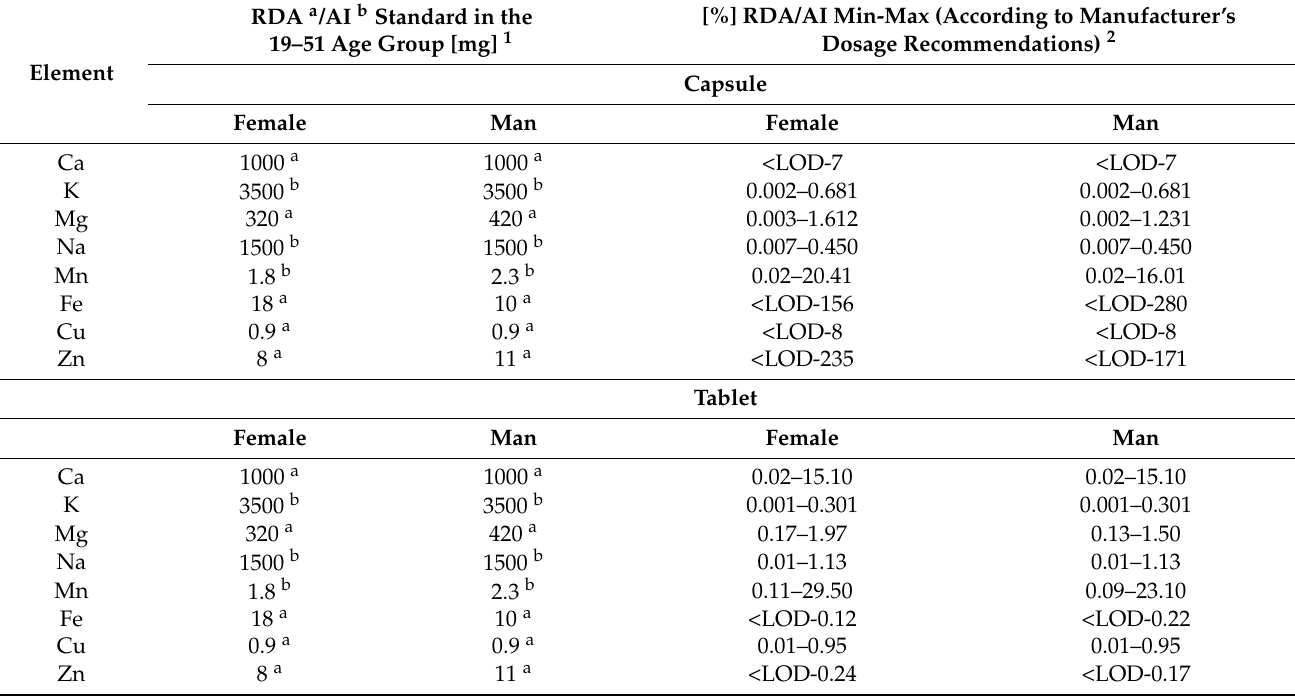
Figure 3. Hierarchical dendrogram for the analysed dietary supplements. GTE—dietary supplements containing green tea extracts; GTE with Cr—dietary supplements containing green tea extracts with chromium; GTE with Cr and fruit extracts—dietary supplements containing green tea extracts with chromium and fruit extracts; GTE with fruit extracts—dietary supplements containing green tea extracts with fruit extracts) and green tea samples. The data concerning green tea are based on Brzezicha-Cirocka et al. [39]. Table 6. Evaluation of RDA/AI [44] for the selected elements in the analysed dietary